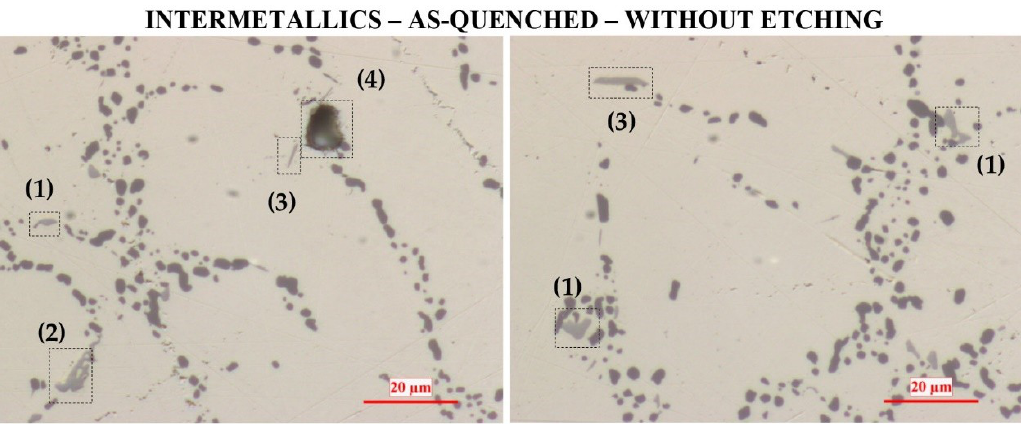
Figure 1. As-quenched intermetallics found in the AlSi7Cu3.5Mg0.15 (Mn, Zr, V) alloy microstructure. (1) Al 7 Cu 2 Fe or Al 3 (Zr,V), (2) α Al(FeMn)Si, (3) β -AlFeSi, (4) H 2 pore.